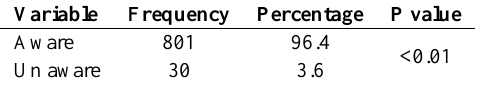
Cross tabulation between the demographics and awareness: Cross-tabulation between the demographics and awareness is